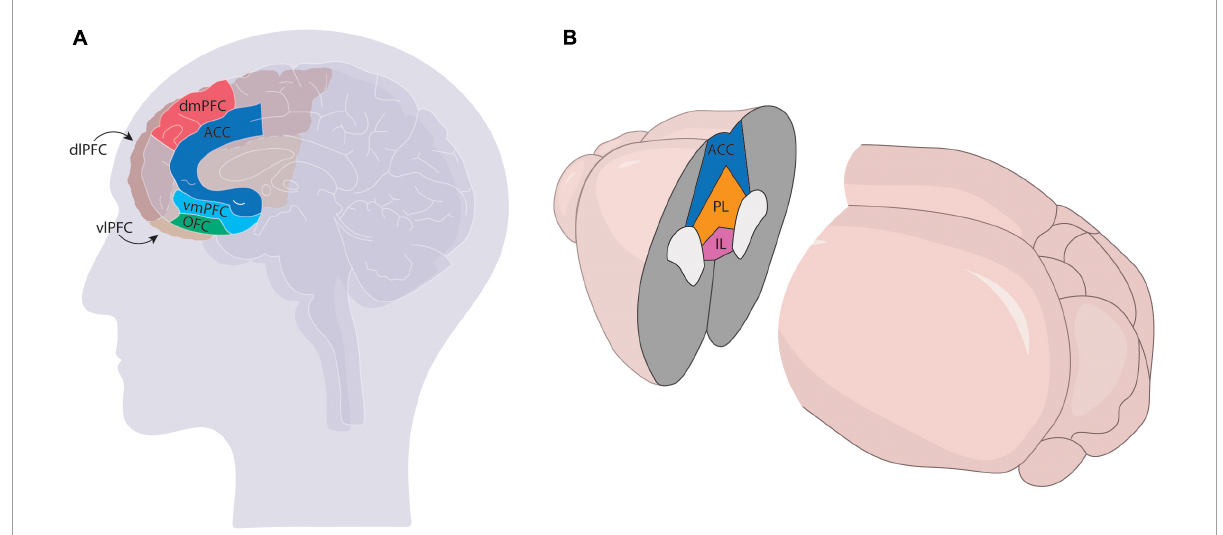
FIGURE1 Comparison of mPFC in the primate (A) and rodent (B) brains. The mPFC has more subdivisions in primates [ventrolateral (vlPFC), ventromedial (vmPFC) dorsolateral (dlPFC), dorsomedial (dmPFC), anterior cingulate (ACC), and orbitofrontal (OFC)] and comprises a larger region of the cortex than the rodent brain, which generally only comprises the infralimbic (IL), prelimbic (PL), and ACC regions.